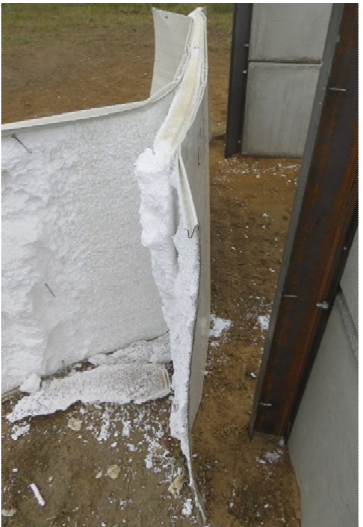
Figure 13. Displacement of the sandwich panel from the supporting structure.